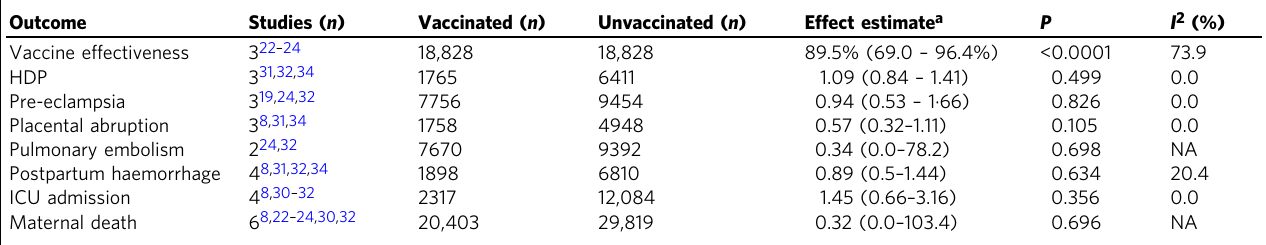
Fig. 1 PRISMA fl ow diagram. Flow diagram summarises the number of studies excluded at each stage. Table 1 Meta-analysis of maternal and perinatal outcomes in studies comparing COVID-19 vaccinated and unvaccinated pregnancies.